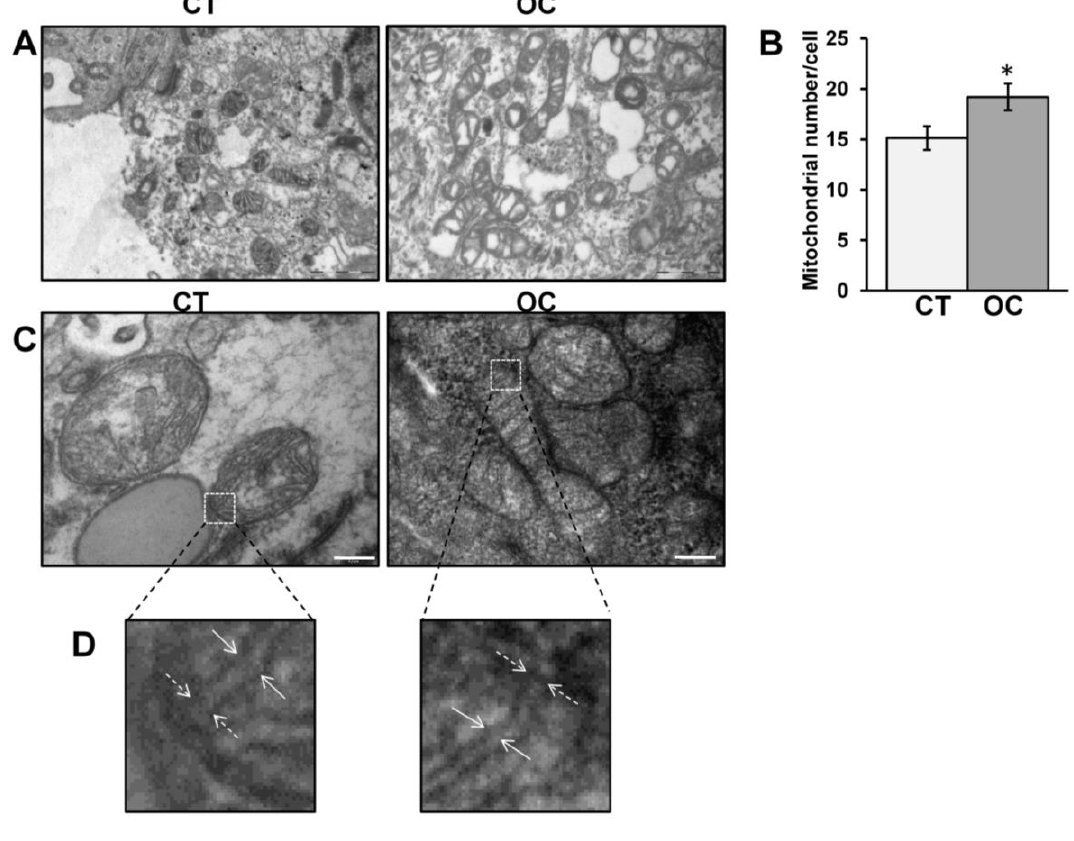
Figure 1. Electron microscopy images of mitochondria in control (CT) and ovarian cancer (OC) tissues. ( A ) Representative images of electron microscopy of semi-thin sections of CT and OC tissue samples (18,000×) (scale bar = 1 μm). ( B ) The histograms represent the means of values of mitochondria number ± standard error of the mean (SEM). ( C ) Representative images of electron microscopy of semi-thin sections of CT and OC tissue samples (56,000×) (scale bar = 0.2 μm) (* p < 0.05, Student’s t -test). For other details, see Section 4. ( D ) Magnification showing mitochondrial cristae width (solid arrows) and mitochondria cristae junction diameter (dashed arrows).